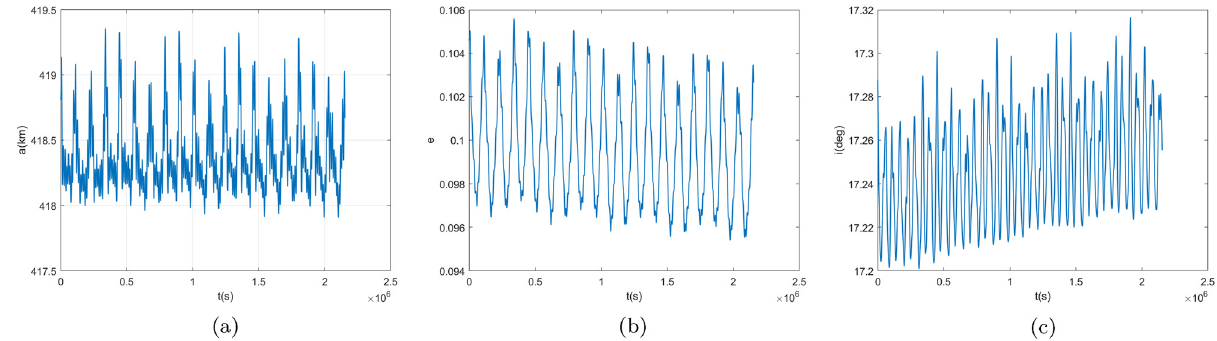
Figure 8: The orbital elements of simulation. ( a ) The semi - major axis. ( b ) The eccentricity. ( c ) The inclination of the orbit relative to the equatorial plane of